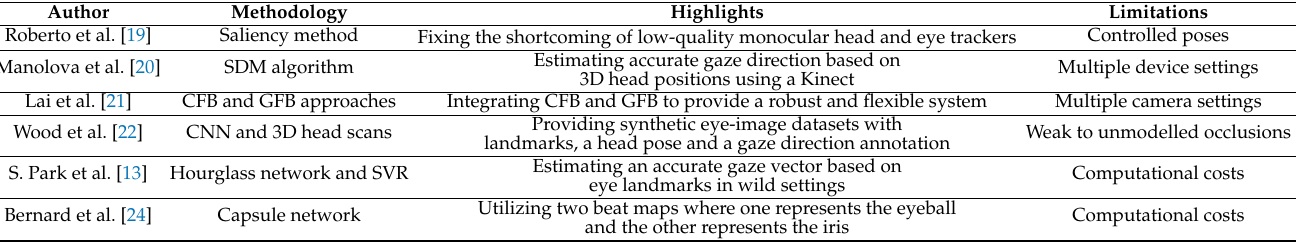
Table 1. A summary table of the feature-based gaze estimation